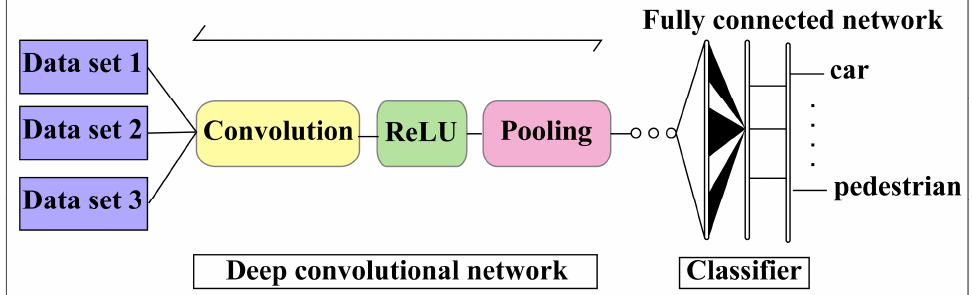
Figure 11. Convolutional neural networking model for DL and AI processing.